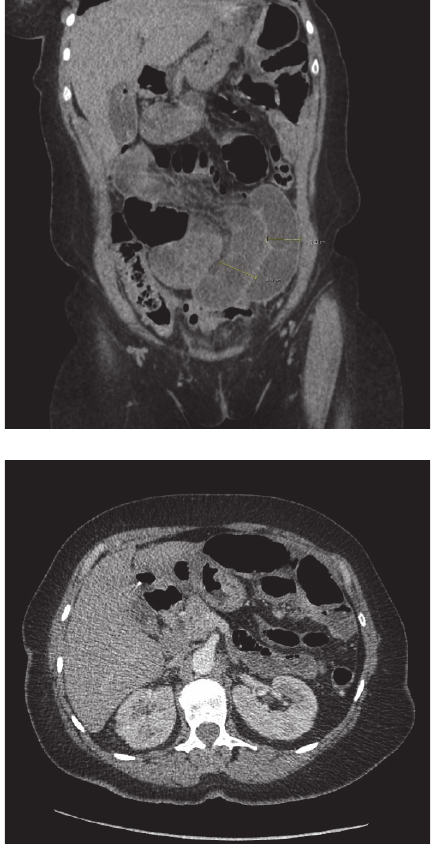
Figure 2: Computed tomography (CT) scan of the abdomen demonstrated early complete bowel obstruction at the level of